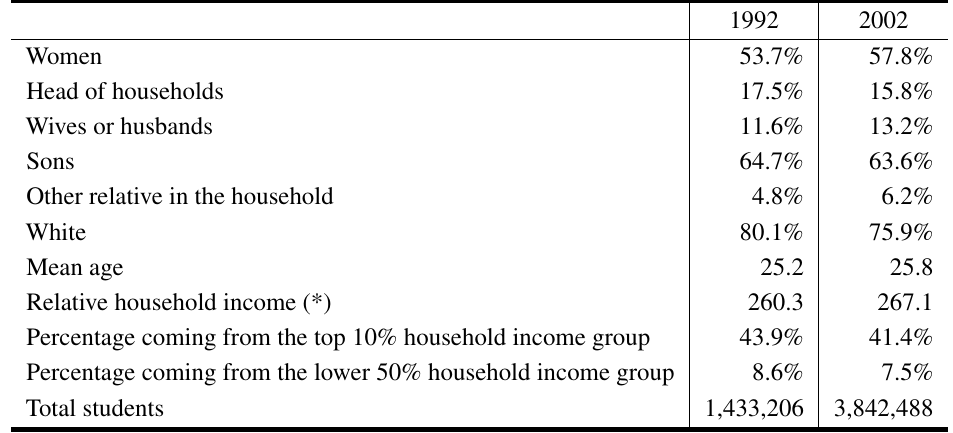
Social characteristics of higher education students, 1992 and